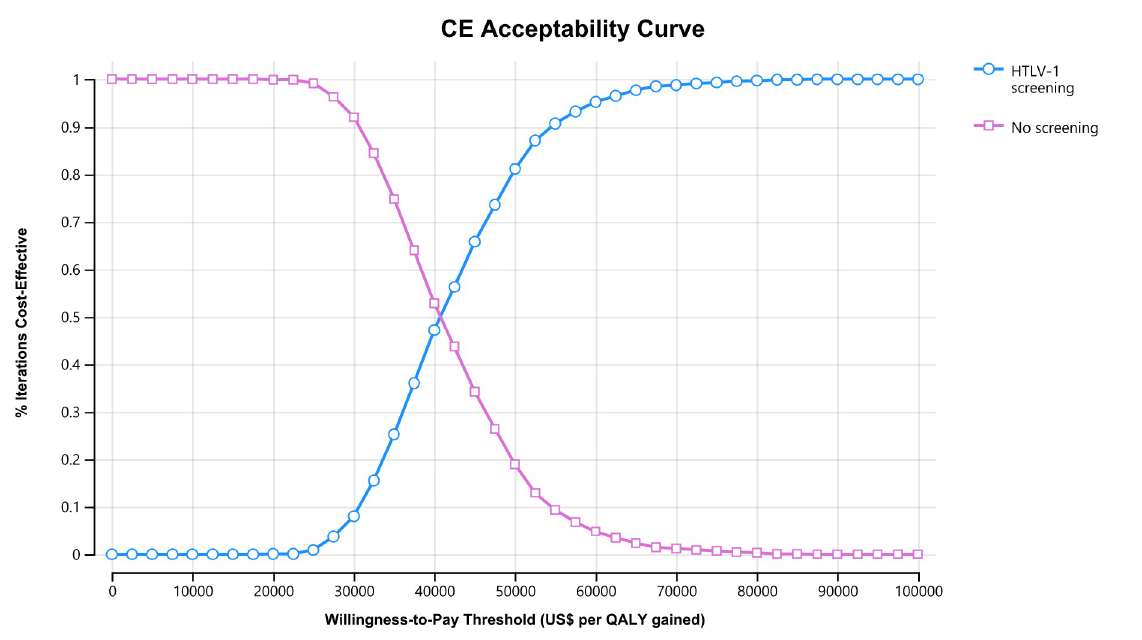
Fig 4. Cost-effectiveness acceptability curve. The probabilistic sensitivity analysis analyzes 1000 simulations of the model in which input parameters are randomly varied across pre-specified statistical distributions. The x-axis represents the WTP threshold. The acceptability curve showed that HTLV-1 antenatal screening is 81.1% cost-effective at a WTP threshold of US$50,000 per QALY gained. CE, cost-effectiveness; QALY, quality-adjusted life-year; WTP, willingness-to-pay; HTLV-1, human T cell leukemia virus 1.